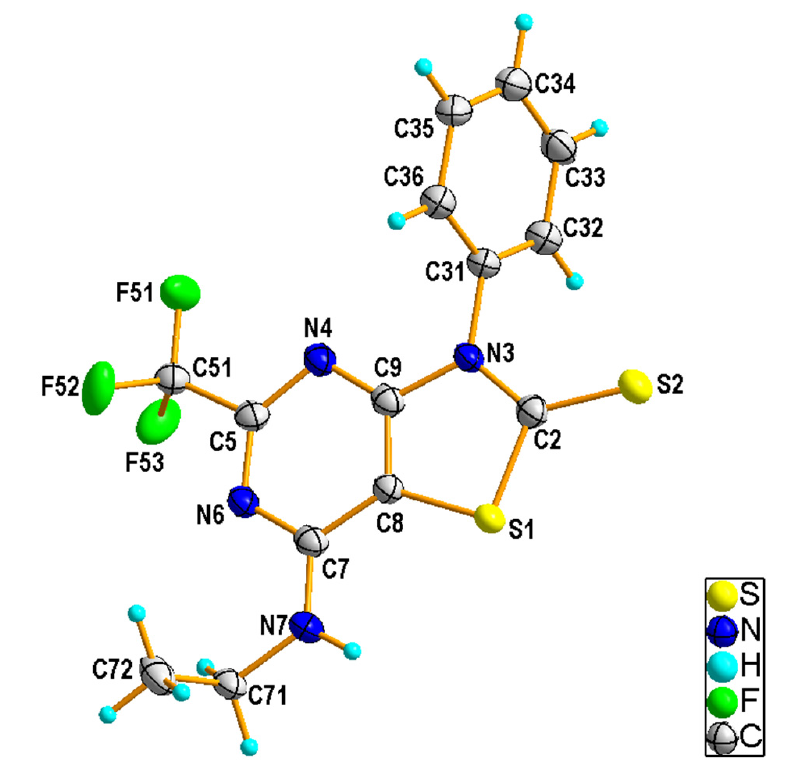
Figure 4. Crystal structure of 4b showing the atom-numbering scheme and displacement ellipsoids drawn at the 50% probability level.